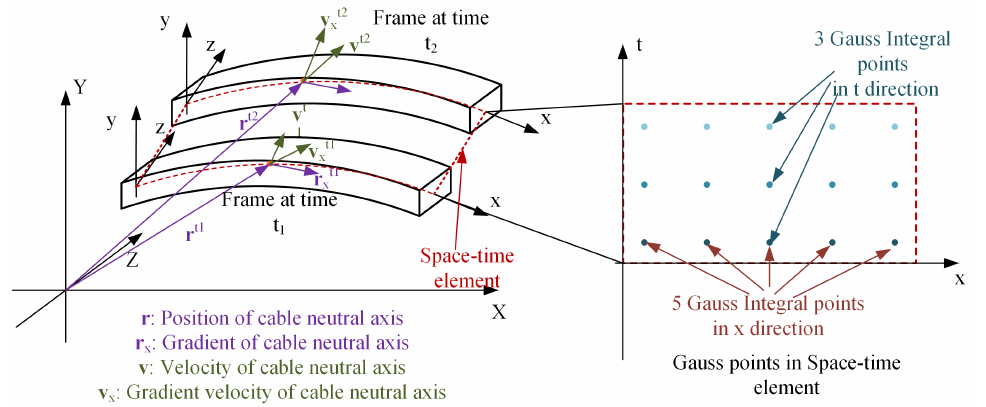
Figure 1. The frame of SAC element and the distribution of Gauss